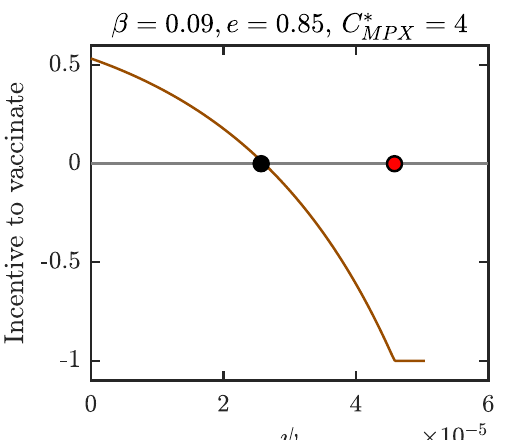
Fig 13. The incentive function for the parameters in the brown region of Fig 9 where ψ NE > 0 is the only NE and CSNE. Full black circle is the CSNE, the red circle corresponds to ψ parameters are as in Table